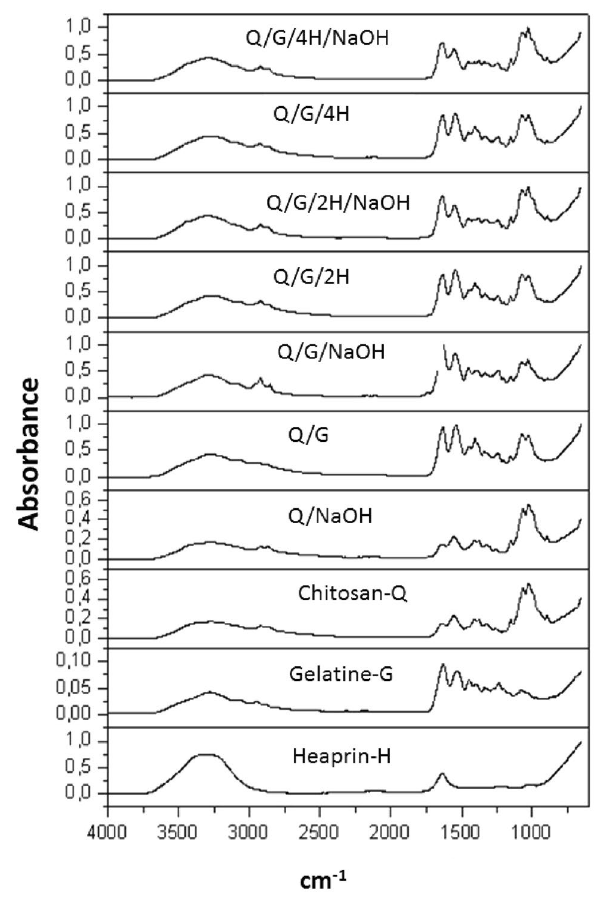
Fig. 2 Fourier Transform Infrared Spectroscopy of gelatin powder and chitosan membranes with and without gelatin and